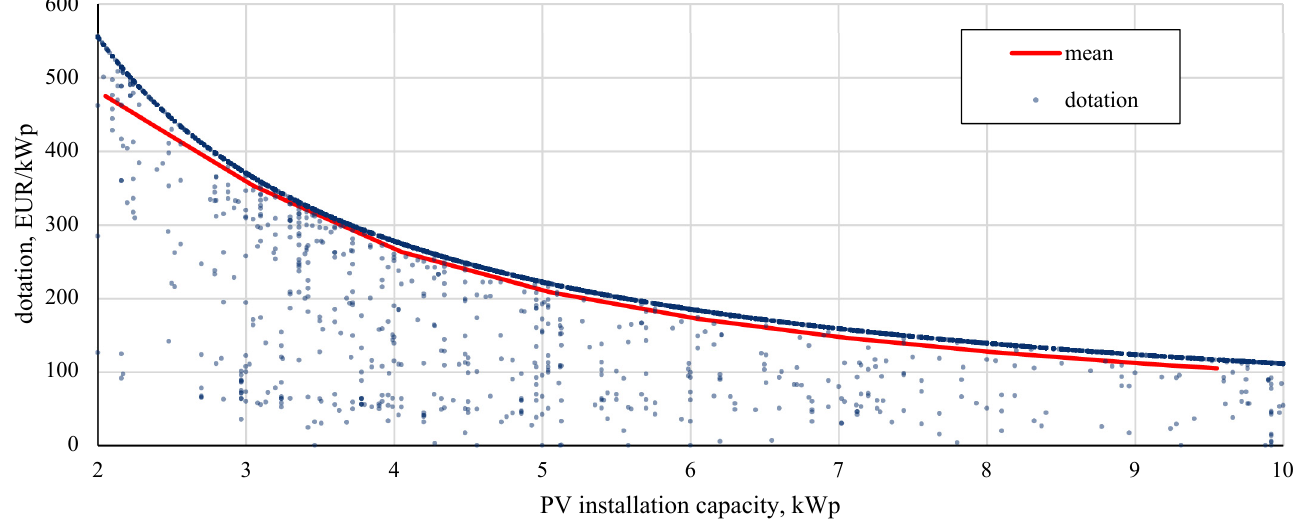
Figure 5. Dependence of the power of the installation on the amount of the subsidy. Source: own study based on [34].